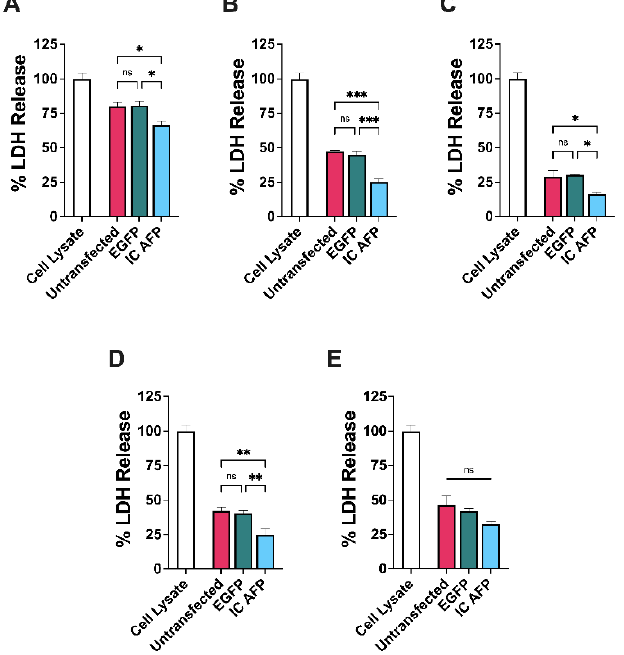
Figure 3. LDH assay of cell damage for untransfected, EGFP-transfected, and EGFP–AFP-transfected (IC AFP) HEK 293T cells after cryopreservation. A total of 5 × 10 6 cells were cryopreserved with